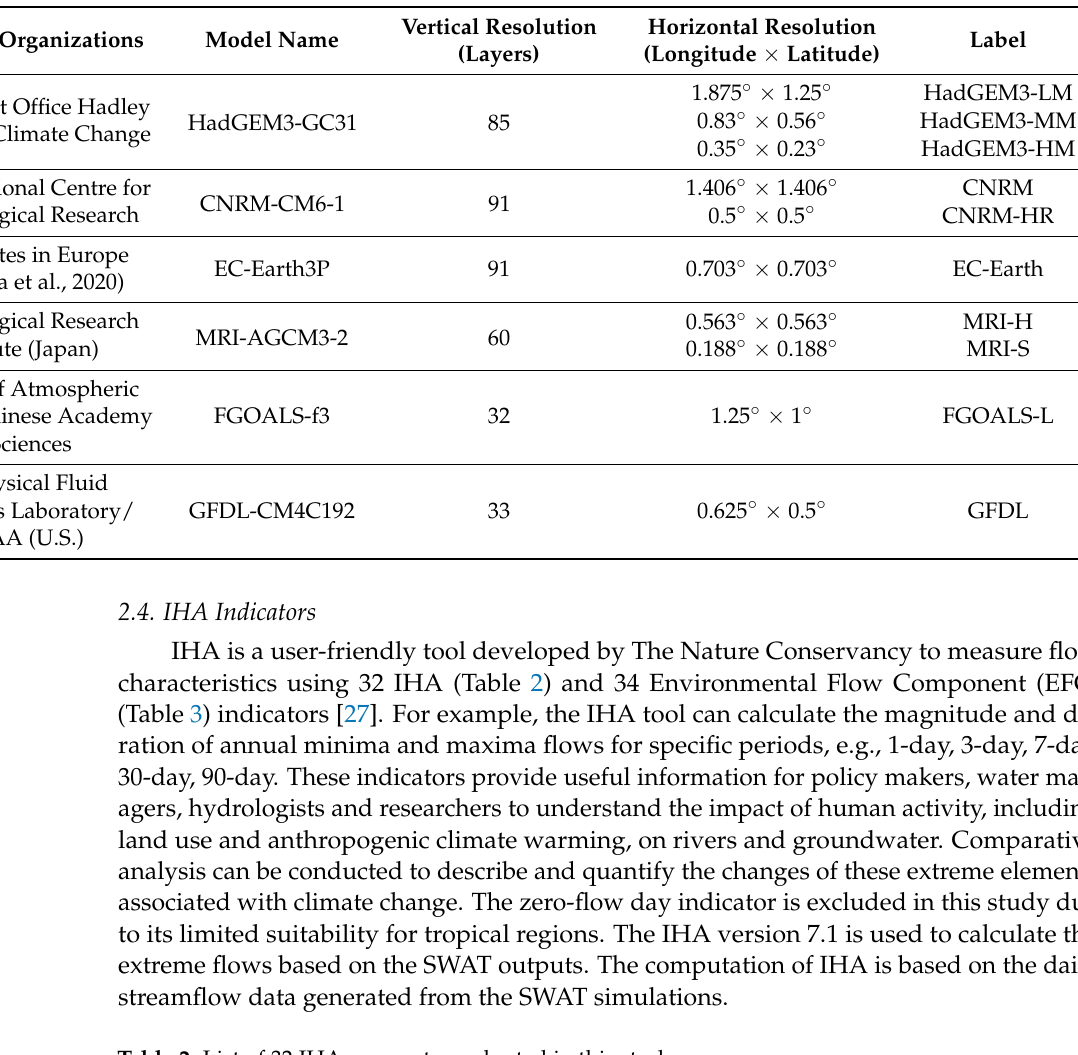
Table 2. List of 32 IHA parameters adopted in this